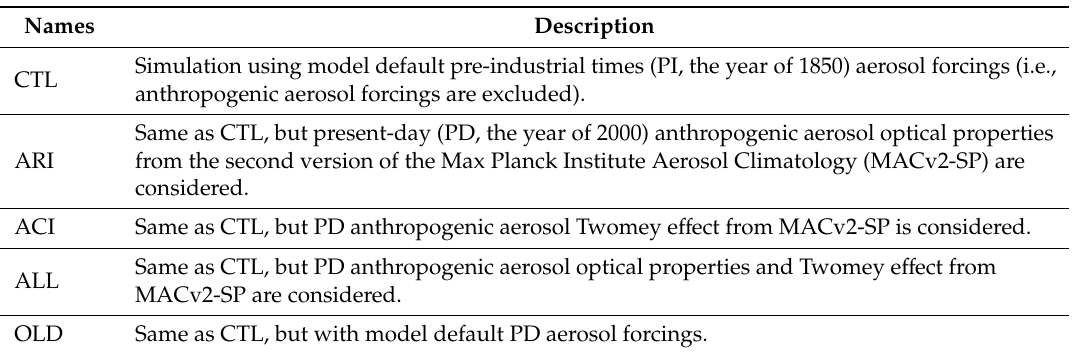
Table 1. List of sensitivity experiments conducted in this